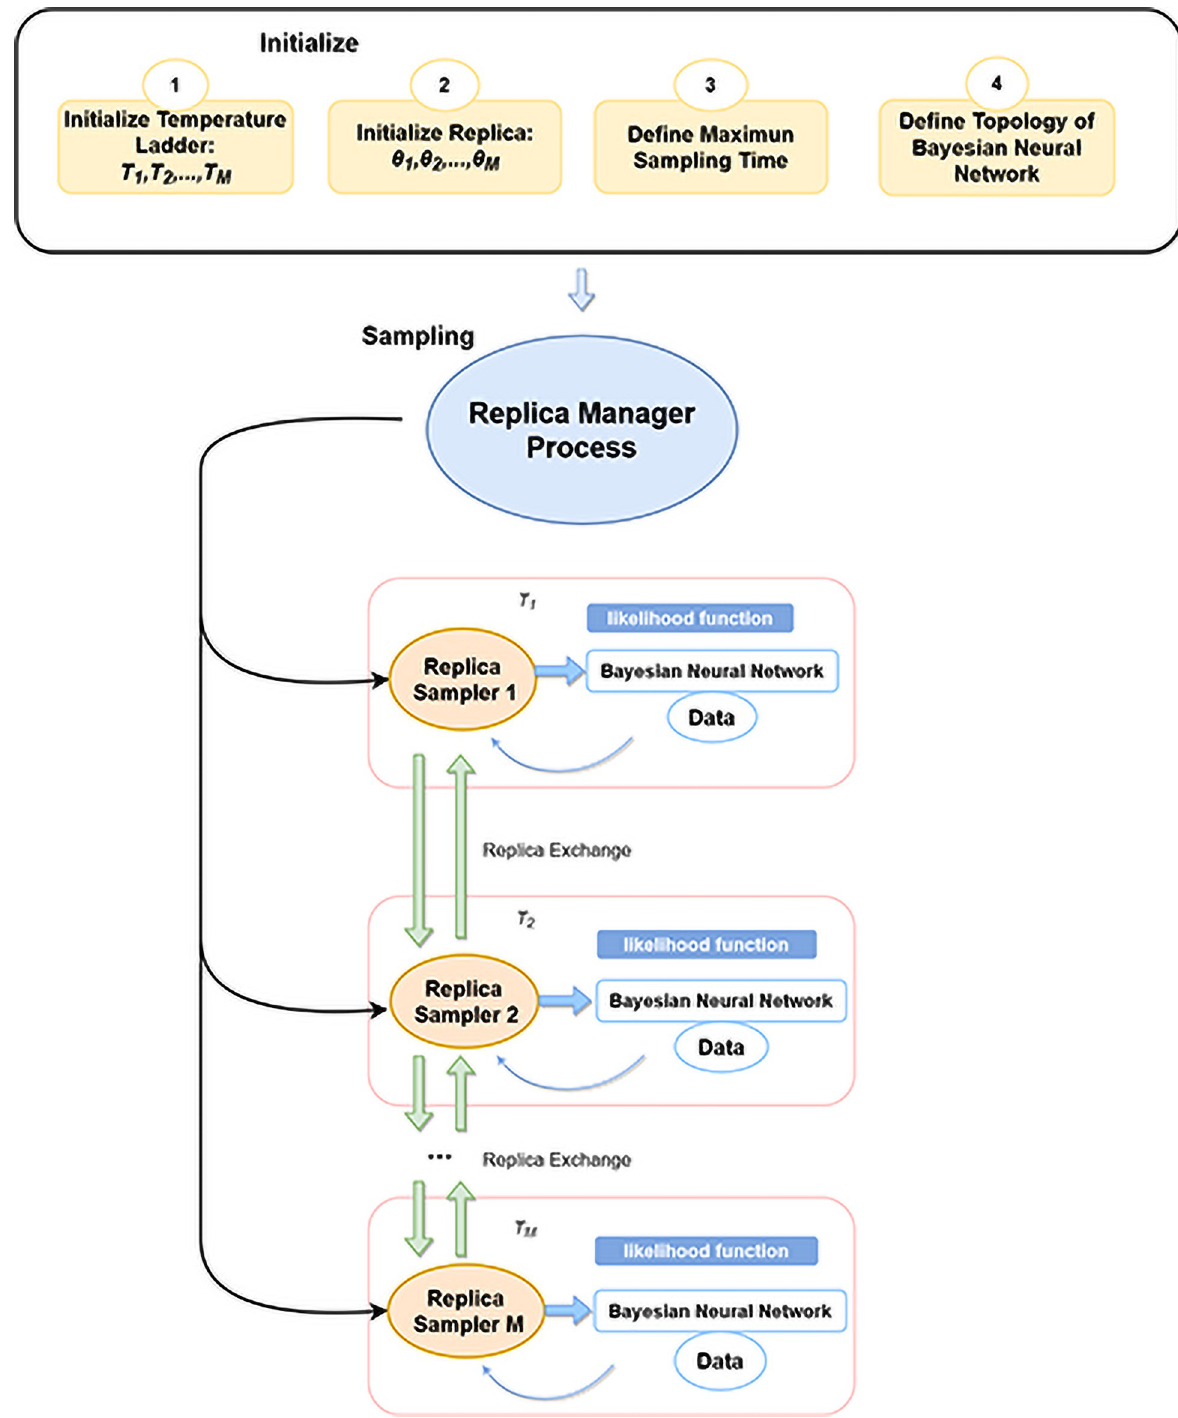
Fig 3. An overview of the different replicas that are executed on a parallel computing architecture.